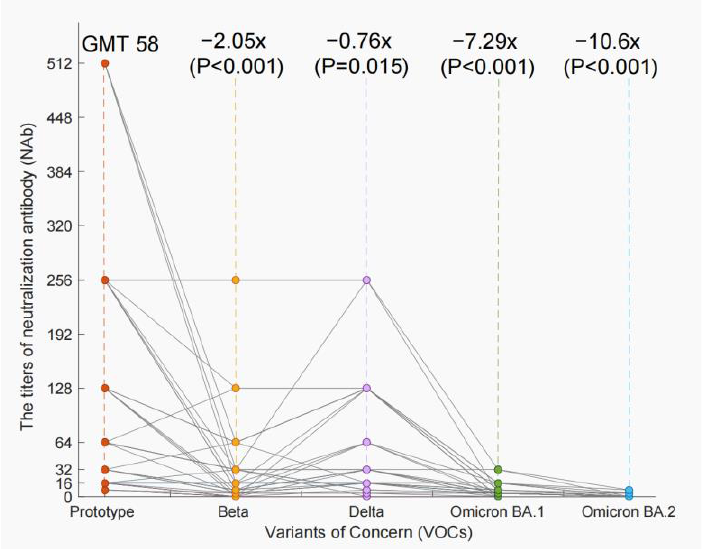
Figure 3. The NAb titers against the prototype virus and a variety of Variants of Concern (VOCs). Neutralization titers against the prototype virus and four VOCs, Beta, Delta, Omicron BA.1, and Omicron BA.2, were tested with the serum of COVID-19 patients. The geometric mean titer (GMT) for the prototype virus was 58, but the VOC Beta decreased to 19 (2.05 fold, p < 0.001), Delta decreased to 33 (0.76 fold, p = 0.015), Omicron BA.1 decreased to 7 (7.29 fold, p < 0.001), and Omicron BA.2 decreased to 5 (10.6 fold, p < 0.001).